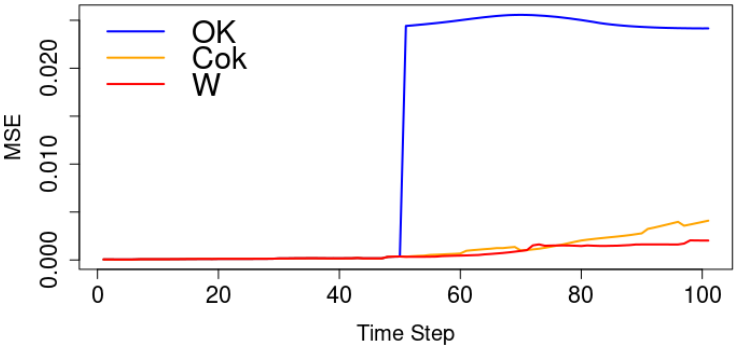
Figure 4. The prediction errors at each time step.